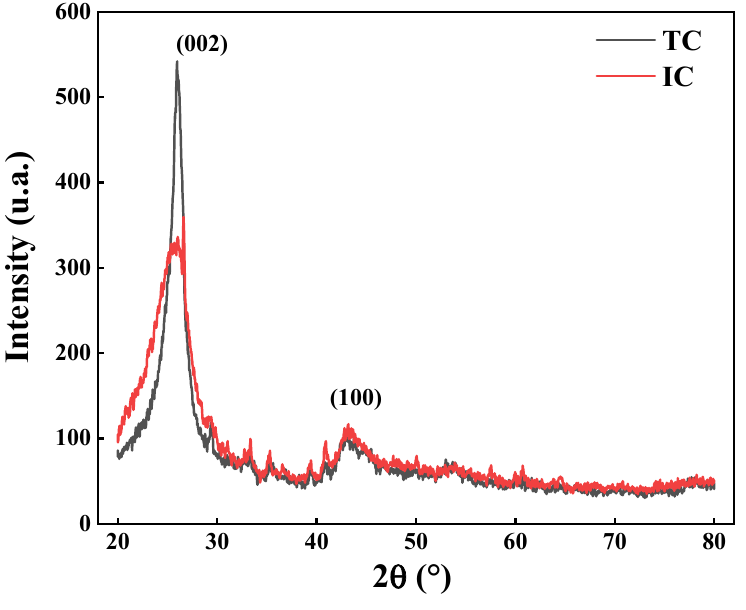
Figure 4. XRD patterns of IC and TC.